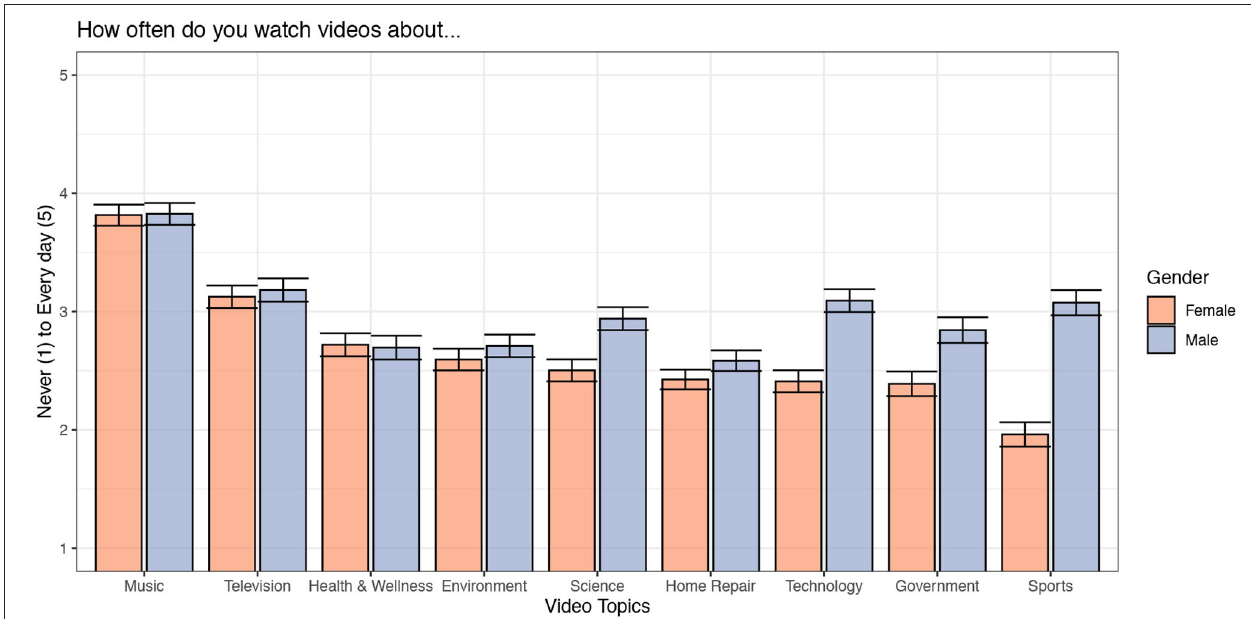
FIGURE 5 | Estimated marginal means. Topics are sorted by females’ ratings. Error bars represent 95% confidence intervals.